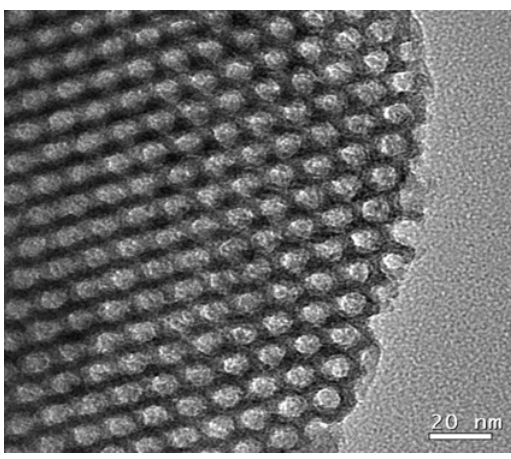
Figure 3. The TEM image of